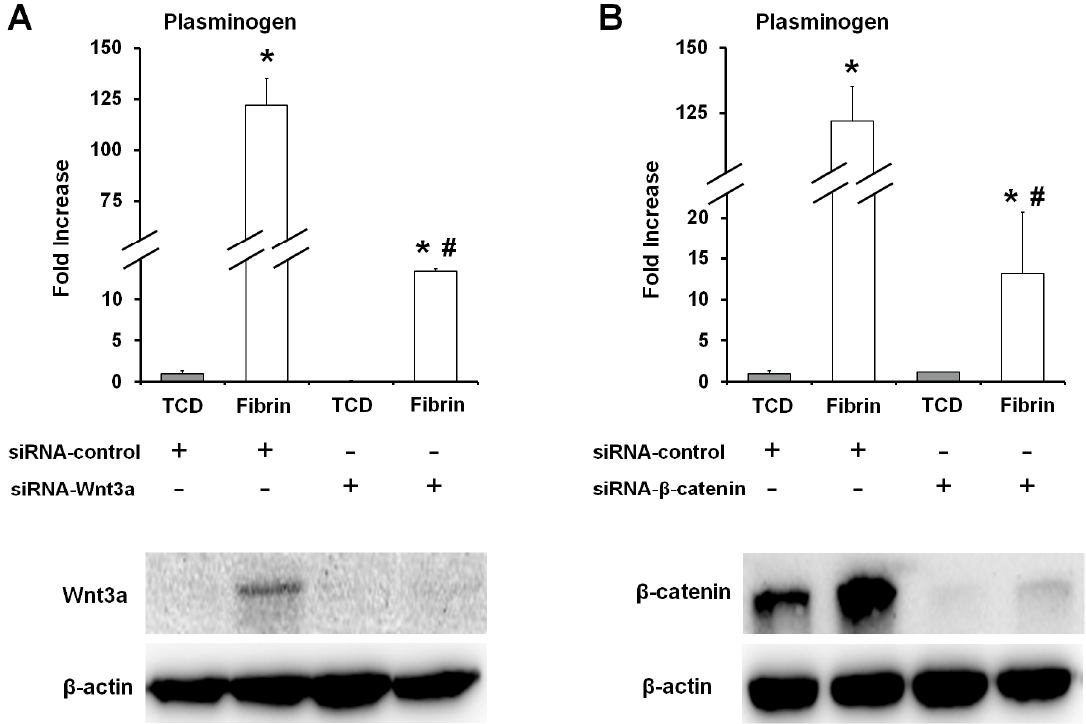
Figure 5. Knockdown of Wnt3a or β -catenin abrogated the fibrin-enhanced plasminogen expression. OCCM-30 cells were transfected with siRNAs against Wnt3a ( A ) and β -catenin ( B ). After 48 h of transfection, the protein levels of Wnt3a and β -catenin were detected by immunoblotting and plasminogen mRNA expression was determined by quantitative real-time PCR normalized to GAPDH. Wnt3a was specifically expressed in OCCM30-fibrin rather than other groups ( A ) but β -catenin expression was determined in OCCM30-TCD and OCCM30-fibrin ( B ). The knockdown models of Wnt3a and β -catenin had no expressions levels. Each experiment was repeated two times independently. * Significantly different from the OCCM30-TCD groups ( p < 0.05), # significantly different from the si-RNA control groups ( p < 0.05).